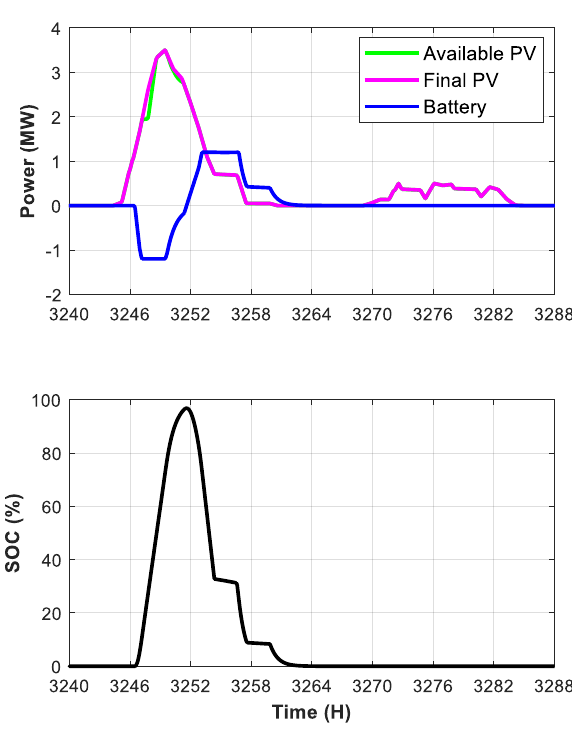
Figure 7. Microgrid operation for two days in winter using the priority EMS Strategy.